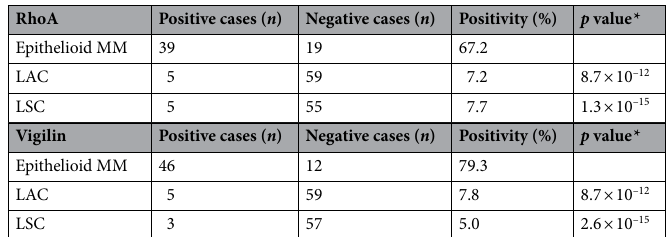
Table 3. Immunohistochemistry data for RhoA and vigilin in epithelioid malignant mesothelioma (MM). * p values show the differences in the result of chi-square test between epithelioid MM and lung cancers. LAC, lung adenocarcinoma, LSC, lung squamous cell carcinoma.